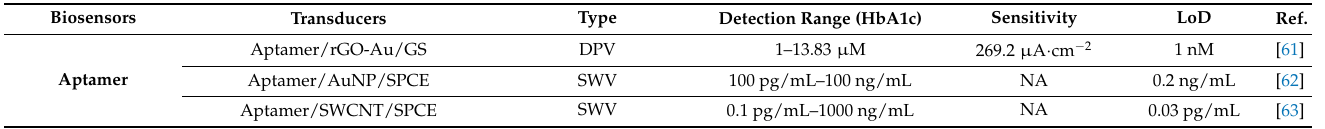
Table 2. Non-boronate biosensors for direct HbA1c